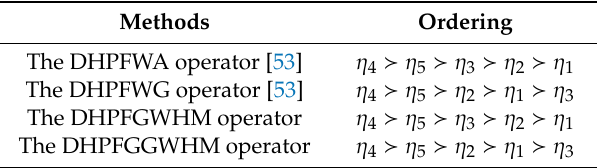
Table 4. Ordering of the suppliers by the DHPFGGWHM